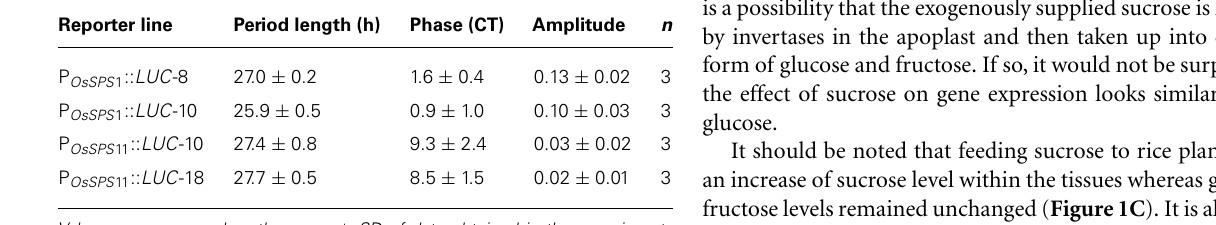
Values are expressed as the mean ± SD of data obtained in the experiments described in Figure 3